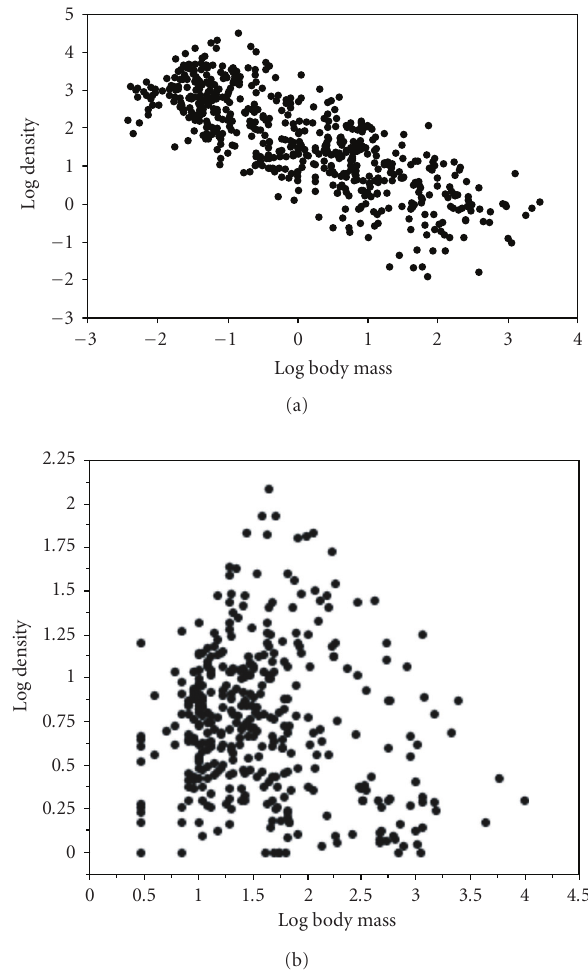
Figure 1: Relationship between the log 10 of body mass and log 10 of density for (a) all mammals (figure based on the original data from Damuth [25]) and (b) birds in North America (figure extracted from Gaston and Blackburn [2]). For mammals, body mass is expressed in kg while density is measured as the number of individuals per km 2 . For birds, body mass is expressed in g while density is measured as the number of individuals per Breeding Bird Survey (BBS) route (see Brown and Maurer [36] for the original dataset description). As it can be seen, body mass is tightly linked to density for mammals (slope = − 0 . 78, r = − 0 . 80, N = 467; from Damuth [25]), while the linear relationship between body mass and density is far less tight for birds (slope = − 0 . 08, r = − 0 . 13, N = 368; these estimates are based on data reconstruction and subsequent analysis from the original data presented in Brown and Maurer [36, Figure